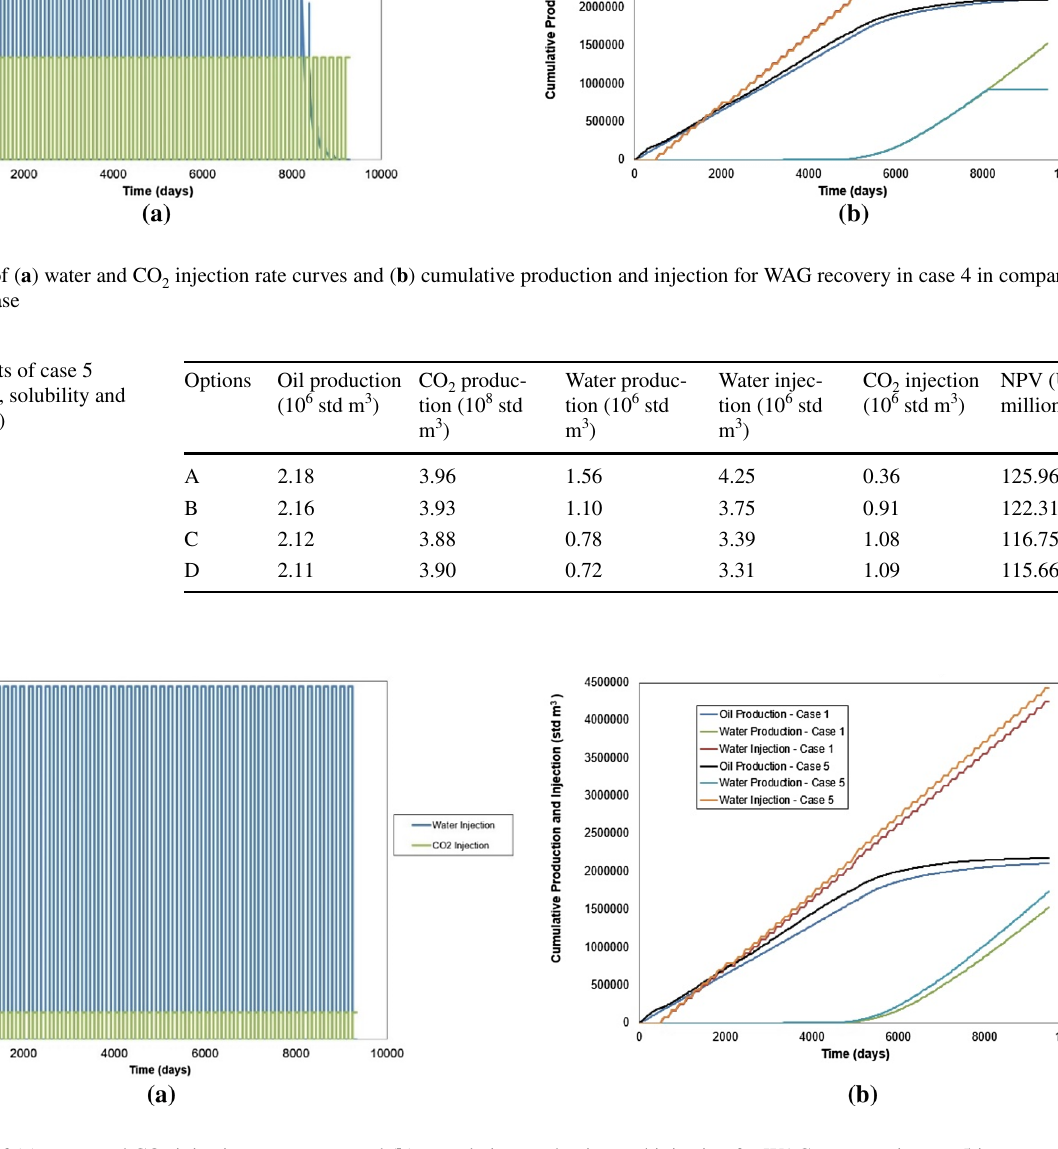
Fig. 8 Graphs of ( a ) water and CO 2 injection rate curves and ( b ) cumulative production and injection for WAG recovery in case 5 in comparison with base